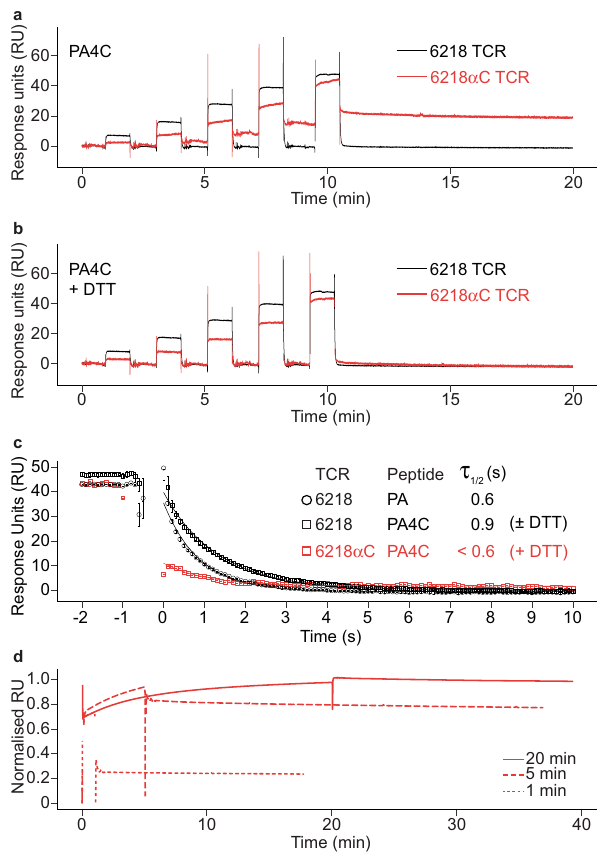
Fig. 6 | S-S bonding between TCR and pMHC proteins in solution. a Persistent binding ofPA4C/H2-D b to6218 α CTCR.SPRsensorgramsof immobilized6218TCR (black) or 6218 α C TCR (red) exposed to PA4C/H2-D b sequentially injected at increasing concentrations. b Abrogation of persistent binding by reducing agent (DTT). PA4C/H2-D b monomers were incubated in 2mM DTT overnight before SPR analysisasin a . c Shorthalf-life ofshort-lived 6218 α C TCR-PA4C/H2-D b complexes. SPR data fora 12-s intervalspanning the transition from pMHCmonomer injection tobufferinjection.Somedatapointsbetween − 0.5sand0sareoutsidethelimitsof the y -axis. Sensorgrams are aligned so that the onset of measurable dissociation occursattime=0.1s.Errorbarsshowtherangeof2experimentsfor6218TCR-PA/ H2-D b ,3experimentsfor6218TCR-PA4C/H2-D b (2withoutDTTand1withDTT)and 1 experiment for 6218 α C TCR-PA4C/H2-D b (with DTT). d Progressive S-S bond formation over a timescale of minutes. SPR sensorgrams for immobilised 6218 α C TCR exposed to 100 μ M PA4C/H2-D b for 1min (dotted line), 5min (dashed line)